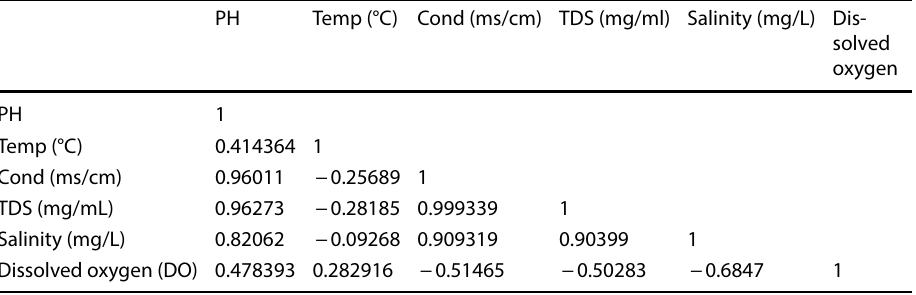
Table 3 Correlation coefficient of physico-chemical parameters measured in Lagos